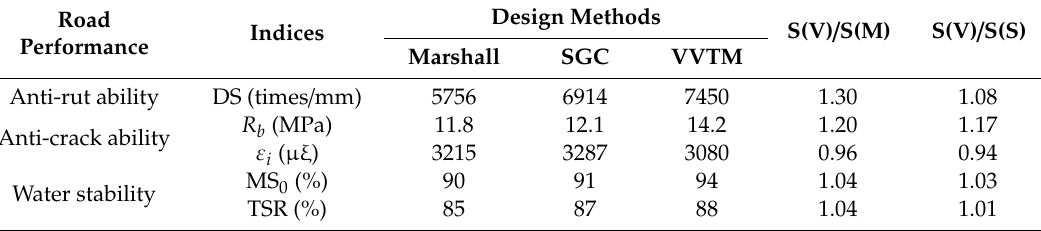
Table 13. Comparison of Road performances of SMA-13 mixtures designed by di ff erent methods.